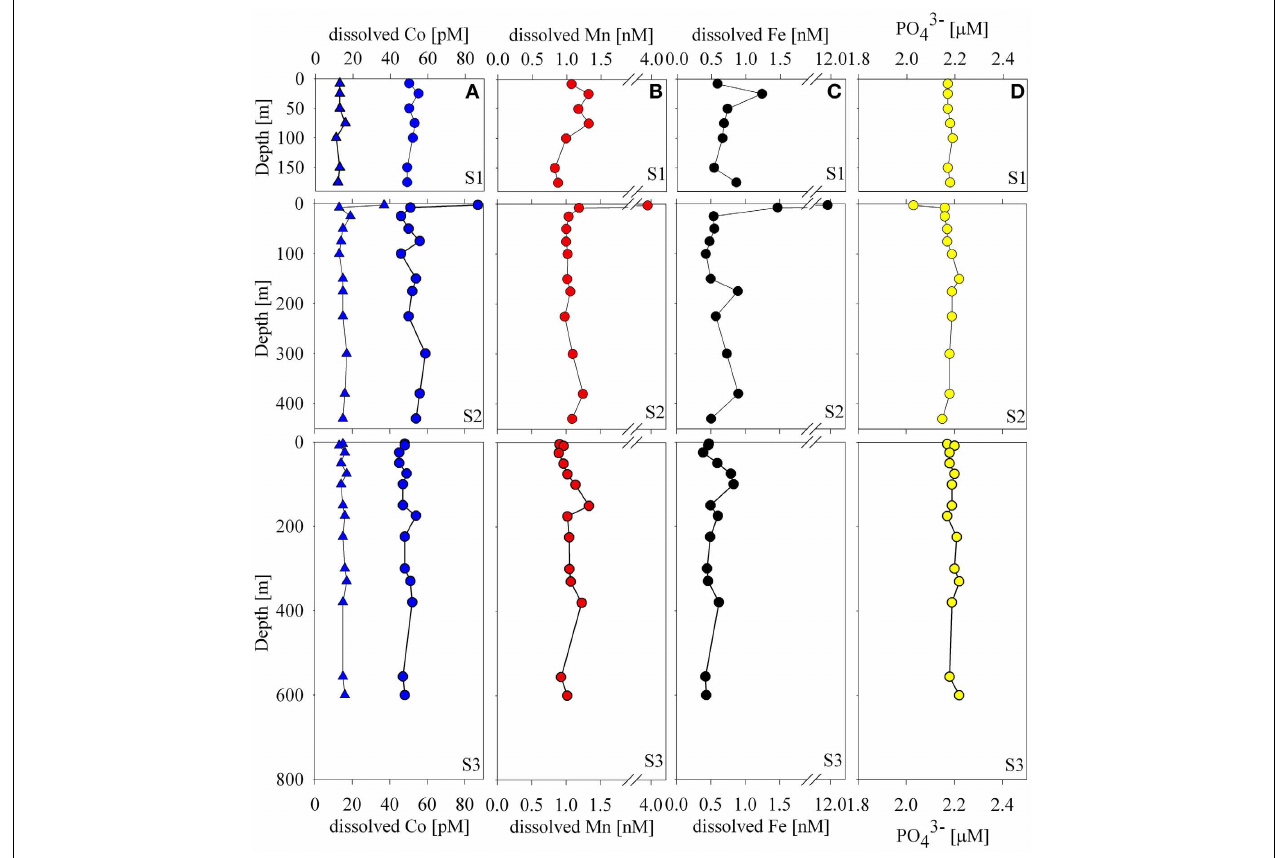
FIGURE 2 | Water column dissolved distributions of cobalt (A), manganese (B), iron, (C), and phosphate (D) at Stations 1–3. Concentrations of total dissolved cobalt, labile cobalt, and phosphate were relatively uniform with the exception of the 4m sample at